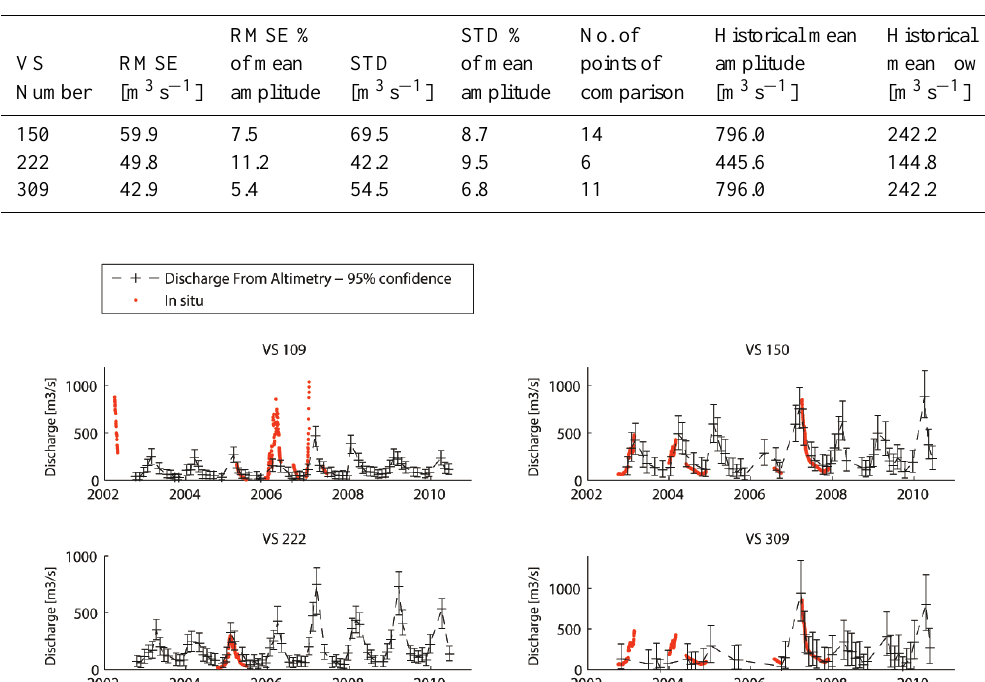
Fig. 5. Comparison of measured and simulated discharge from altimetry and field measured cross section and flow with 95% confidence intervals.